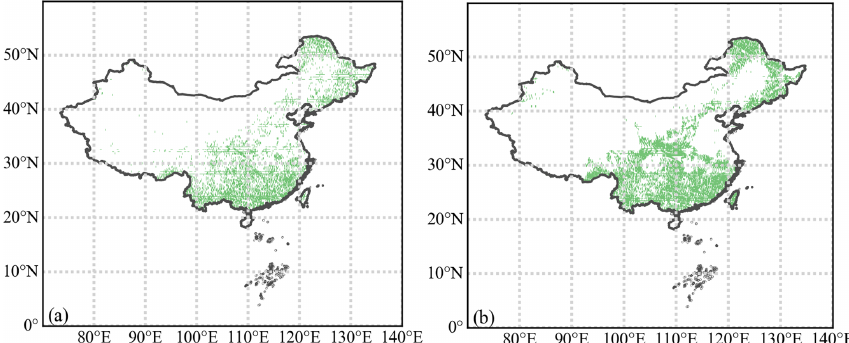
Figure A1. The distributions of the original sample pixels (at a 1km resolution) for (a) the actual effect and (b) the two potential effects.